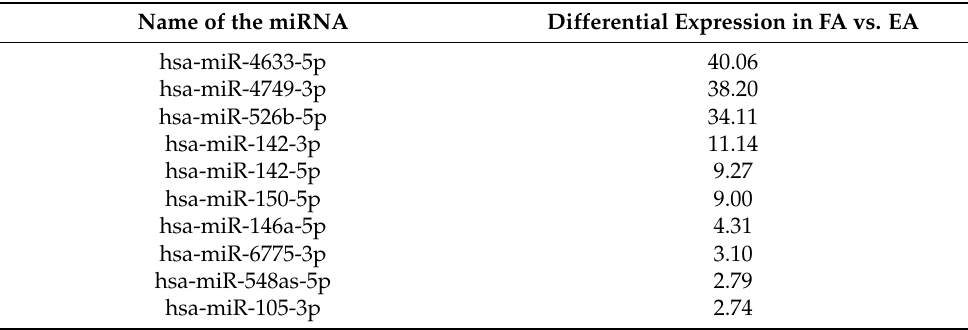
Table 2. Top ten upregulated miRNAs (FA vs. EA).